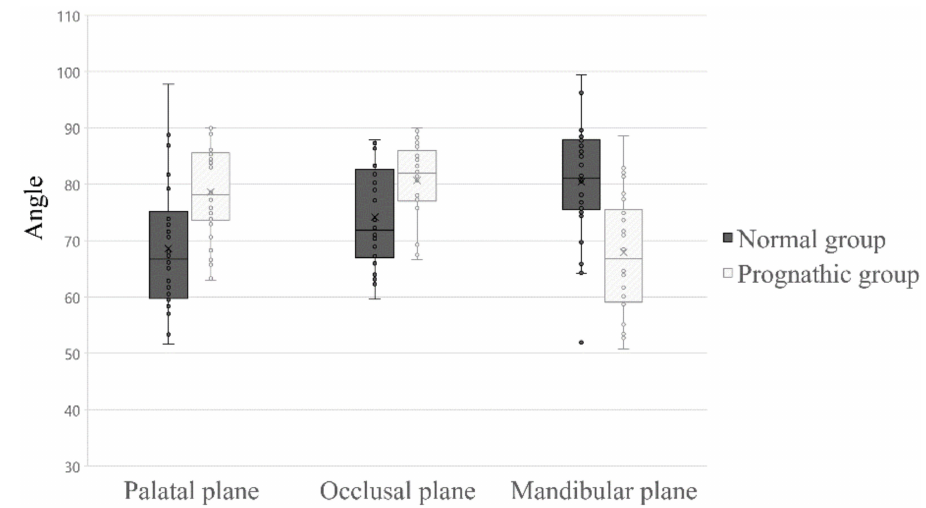
Figure 5. The distribution of the angle of superficial masseter muscle in three planes: palatal, occlusal, and mandibular. All three angles showed significant differences. The participants of the normal group had a greater vertical angle to the mandibular plane than those of the prognathic